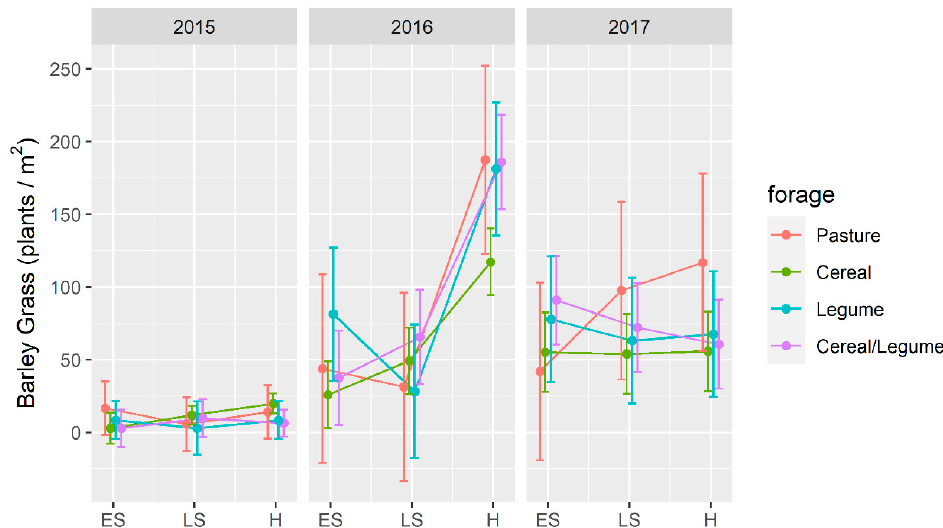
Figure 4. Barley grass density (plants/m 2 ) in a wheat crop in the year following winter forage crops grown at Wagga Wagga, NSW compared to an unsown pasture. Forage crops were grown in 2015-2017, and harvested as early silage (ES), late silage (LS) or hay (H). Data displayed as the mean (•) ± 2 x standard error (length of line in each direction).